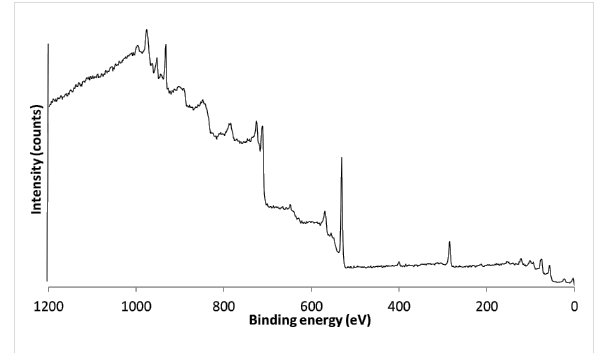
Figure 2: XPS spectrum showing APTES functionalized SPION, the bands at 103, 287 and 402 eV correspond to the presence of silicon, carbon and nitrogen on the surface of the